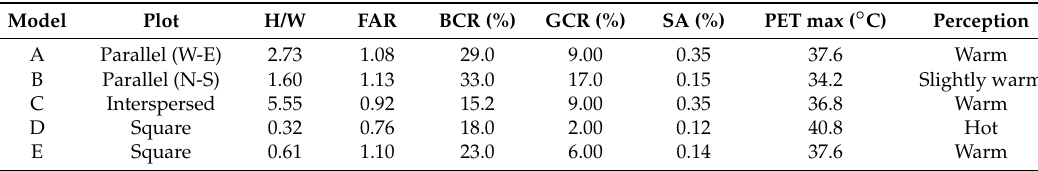
Table 2. Building Form and Configuration.